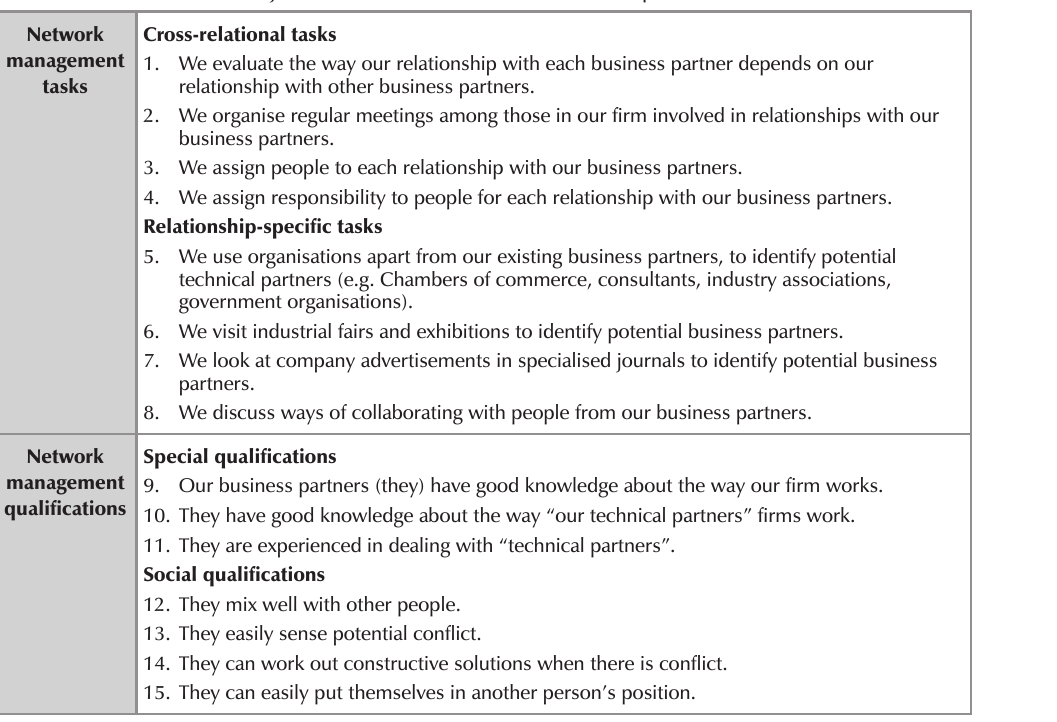
Adjusted 15-item scale for network